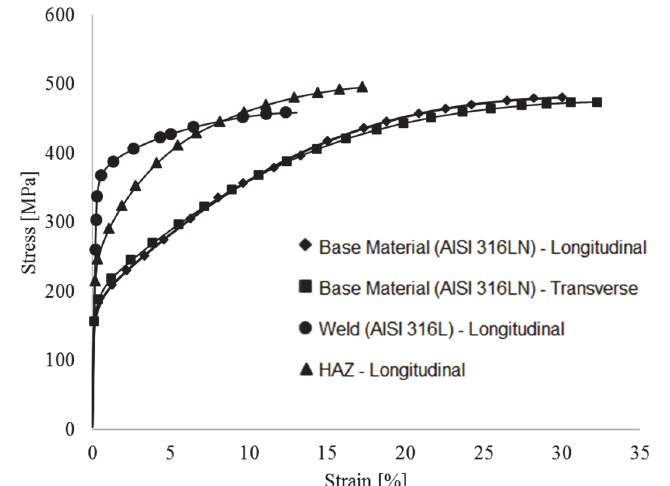
Figure 1: Typical Stress x Strain curves for different zones in the welded pipe.